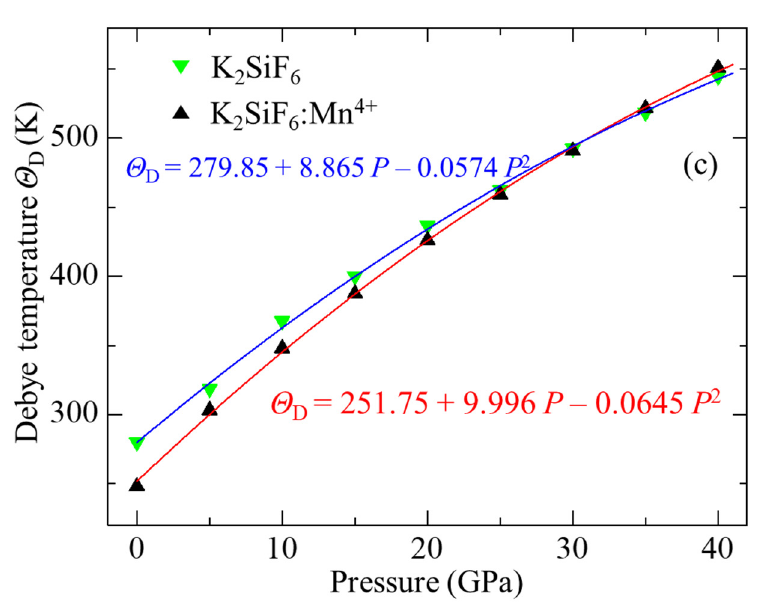
Figure 3. Calculated ( a ) shear moduli, ( b ) sound velocities and ( c ) Debye temperatures for the non-doped and Mn 4+ -doped K 2 SiF 6 as a function of pressure.